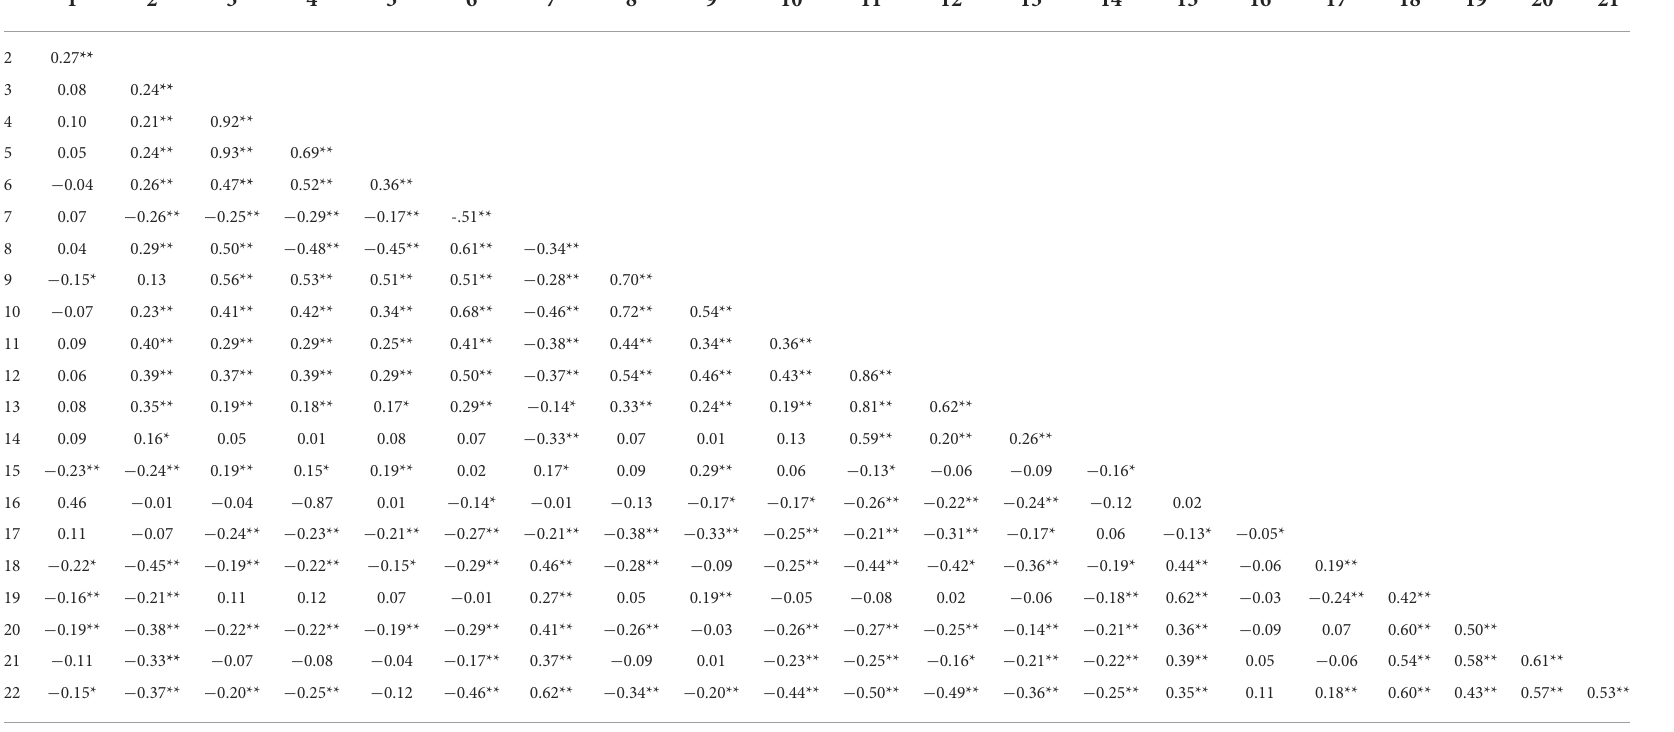
TABLE 4 Correlations between